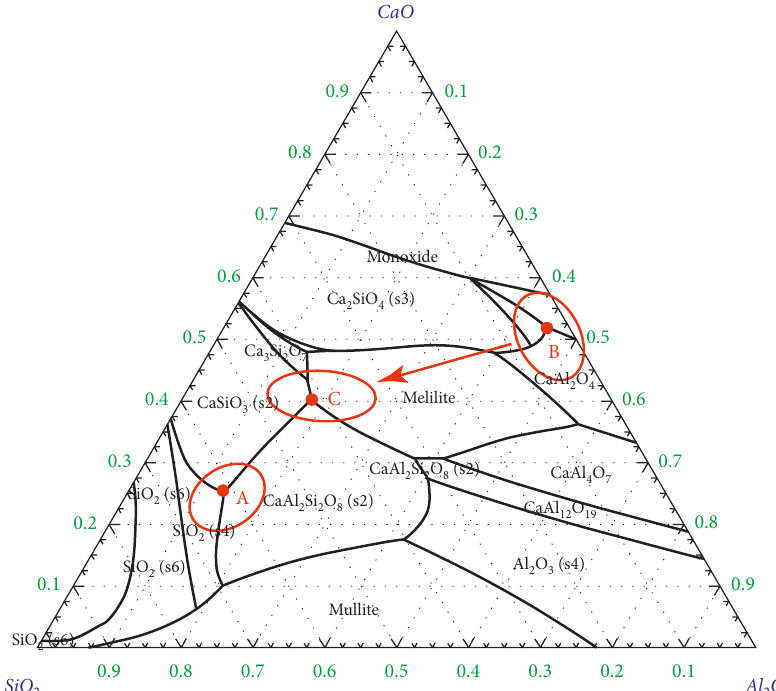
Figure 1: Phase diagram of CaO-SiO